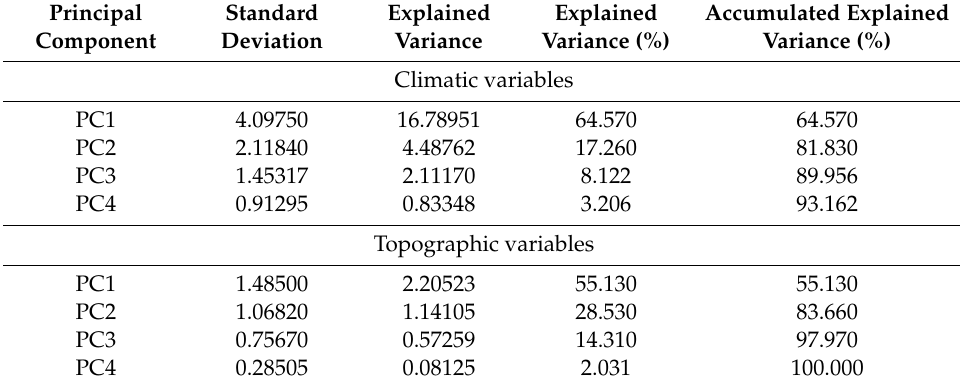
Table 3. Statistical summary of four principal components obtained in the analysis for 26